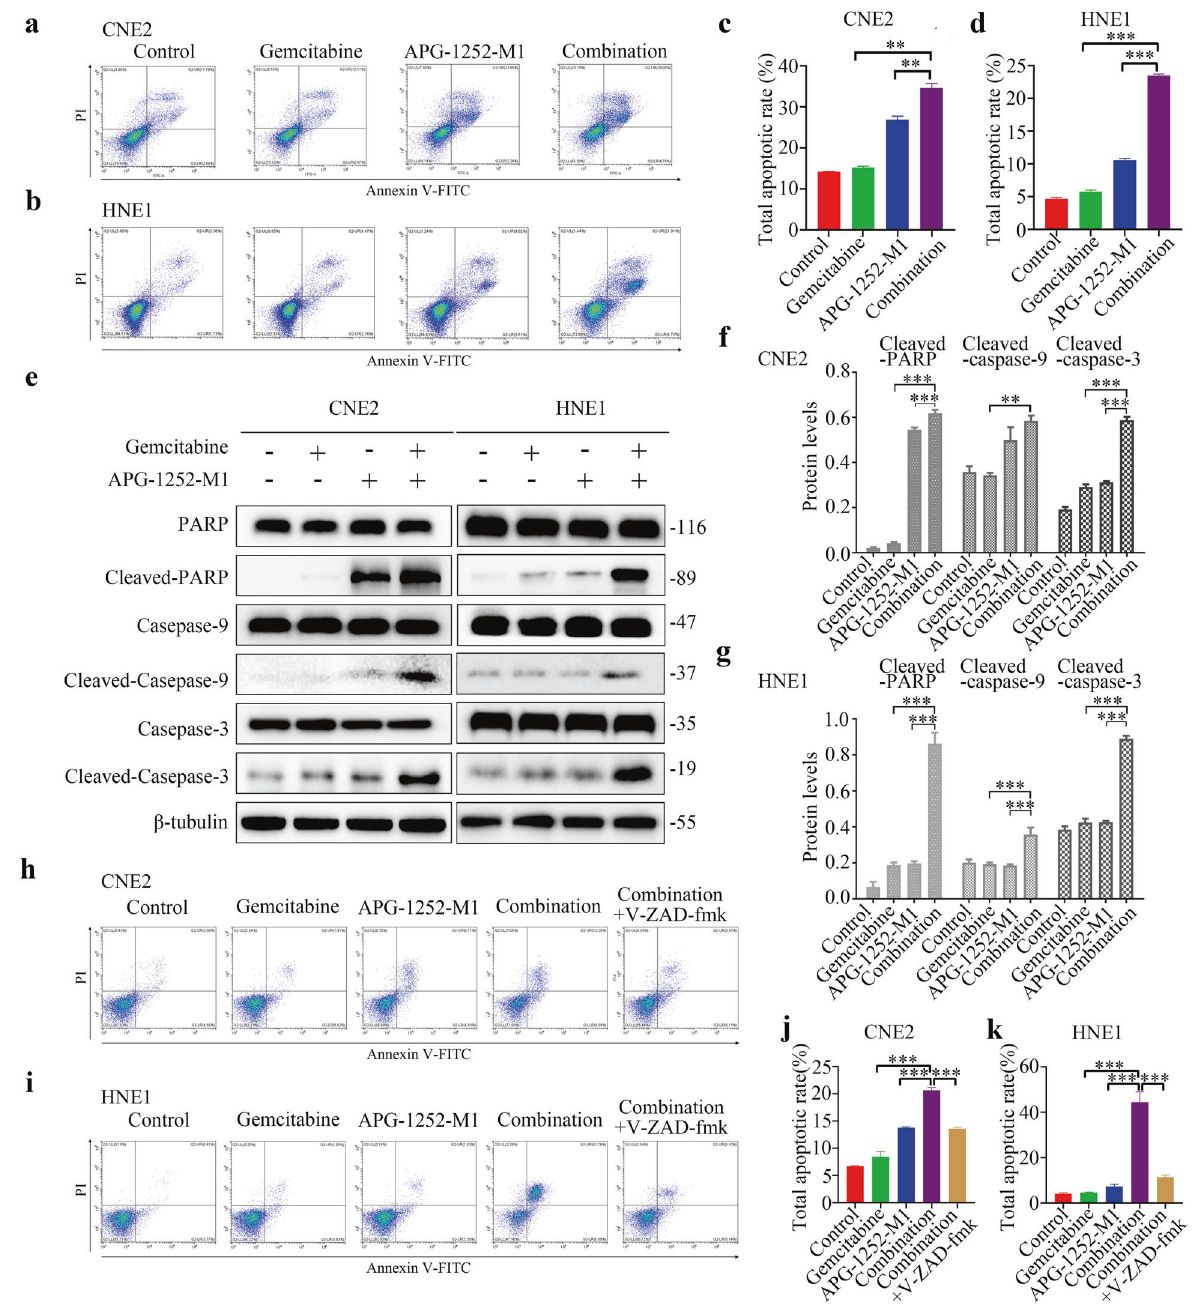
Fig. 2 APG-1252-M1 and gemcitabine depend on caspase to induce NPC cell apoptosis. a – d Annexin V/PI analysis of CNE2 and HNE1 cells following 24 h of exposure to different treatments. The experiments were conducted in triplicate, and the data are shown as the mean±SD. * P < 0.05, ** P < 0.01, *** P < 0.001. e – g Western blotting was applied to detect cleaved PARP, cleaved caspase-3, and cleaved caspase-9 levels as indicators of apoptotic cell death. β -tubulin was used as a loading control. h – k Quanti fi cation of apoptotic CNE2 and HNE1 cells. Annexin V/PI analysis of CNE2 and HNE1 cells following 24 h of exposure to different treatments, including APG-1252-M1 and gemcitabine, or z-VAD-fmk in combination with the two drugs. The experiments were conducted in triplicate, and the data are shown as the mean±SD. * P < 0.05, ** P < 0.01, *** P < 0.001. Error bars indicate the standard deviation of three independently performed experiments. NPC nasopharyngeal carcinoma, PI propidium iodide, PARP poly (ADP-ribose)